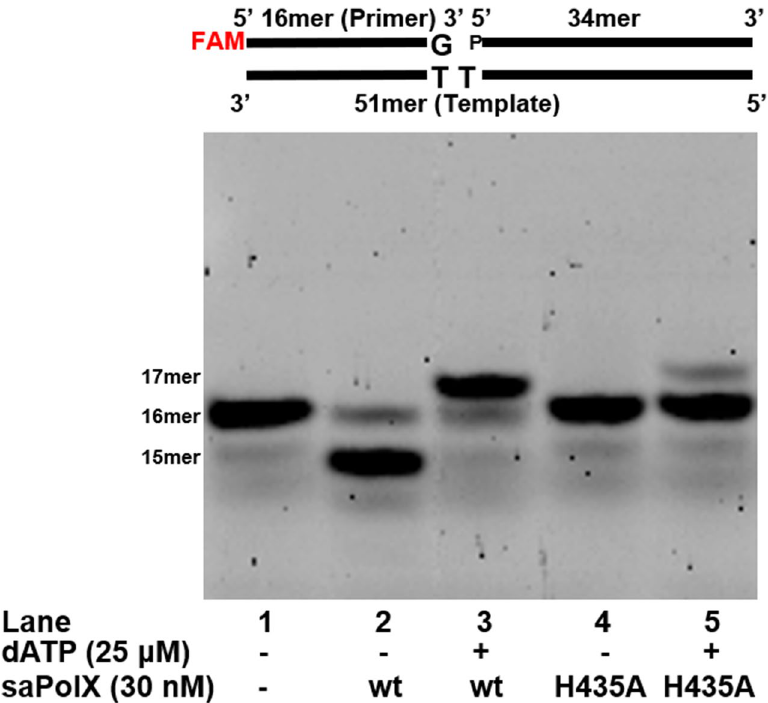
Figure 13. Polymerase activity on mismatched base pair by saPolX. The polymerase activity of wt and H435A exo- mutant were tested on the mismatched gapped DNA substrate. The mismatched gapped DNA substrate (T:G) is displayed at the top of the gel. The result shows that wt-saPolX removes the mismatched base dGMP paired opposite templating base dT and then extends it efficiently by incorporating dATP. H435A mutant does not remove the mismatched base pair and shows less incorporation of dATP. The experiment shows that exonuclease activity residing in the PHP domain of saPolX proofreads the misincorporated base pair which is extended by the polymerase domain of